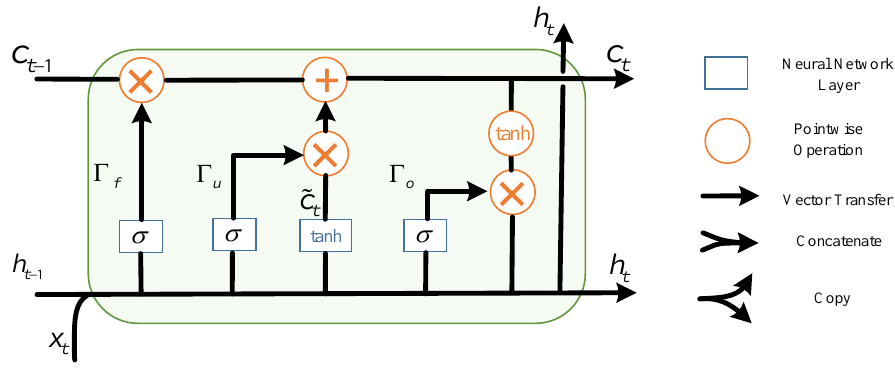
Figure 1. The structure of long-short term memory (LSTM).